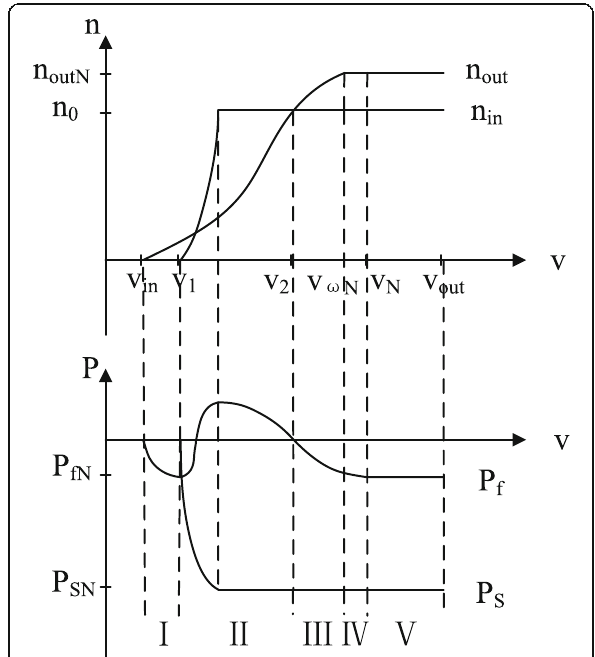
Fig. 4 Speed and power of the double rotor speed-regulating wind power generation system. In Fig. 4, v is the wind speed, n out is the rotational speed of the outer rotor, n outN is the rated rotational speed of the outer rotor, n in is the mechanical speed of the inner rotor, n 0 is the synchronous speed, P f is the electrical power of the speed regulating generator, P fN is the rated electrical power of the speed regulating generator, P S is the output power of the synchronous generator, and P SN is the rated output power of the synchronous